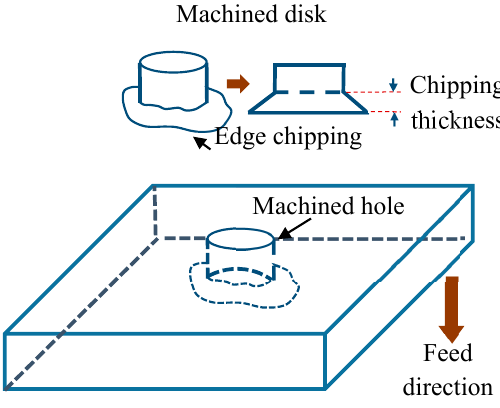
Figure 4. Illustration of edge chipping.